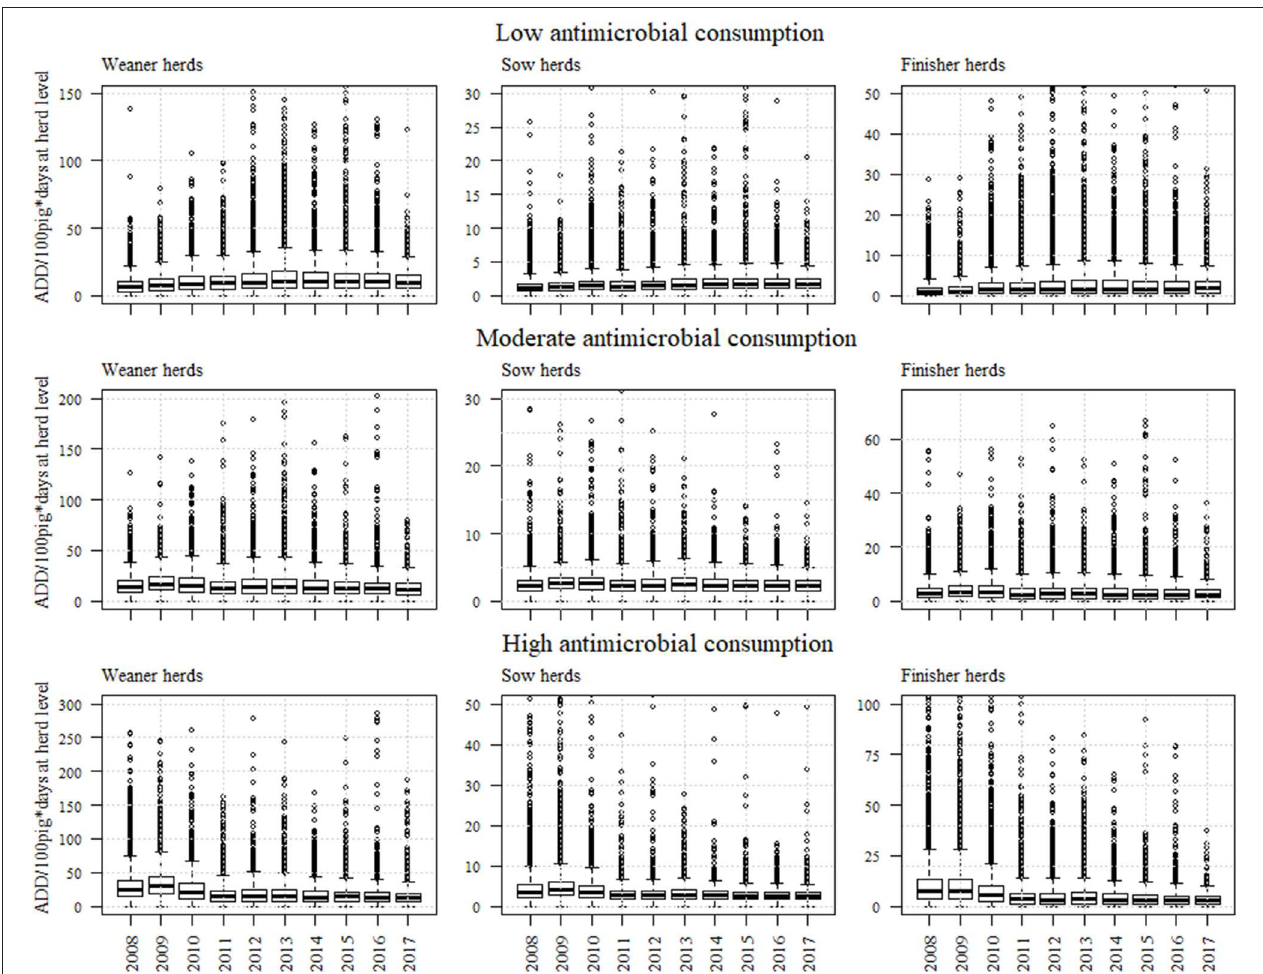
FIGURE 1 | Boxplots with yearly antimicrobial consumption in weaners, sows, and finisher herds within different categories of consumption between 2008 and 2017. The medians obtained from the model are visualized more detailed in Figures 2 – 4 . The categories were calculated based on data from 2008 and 2009 based on the median and on the 3rd quartile as